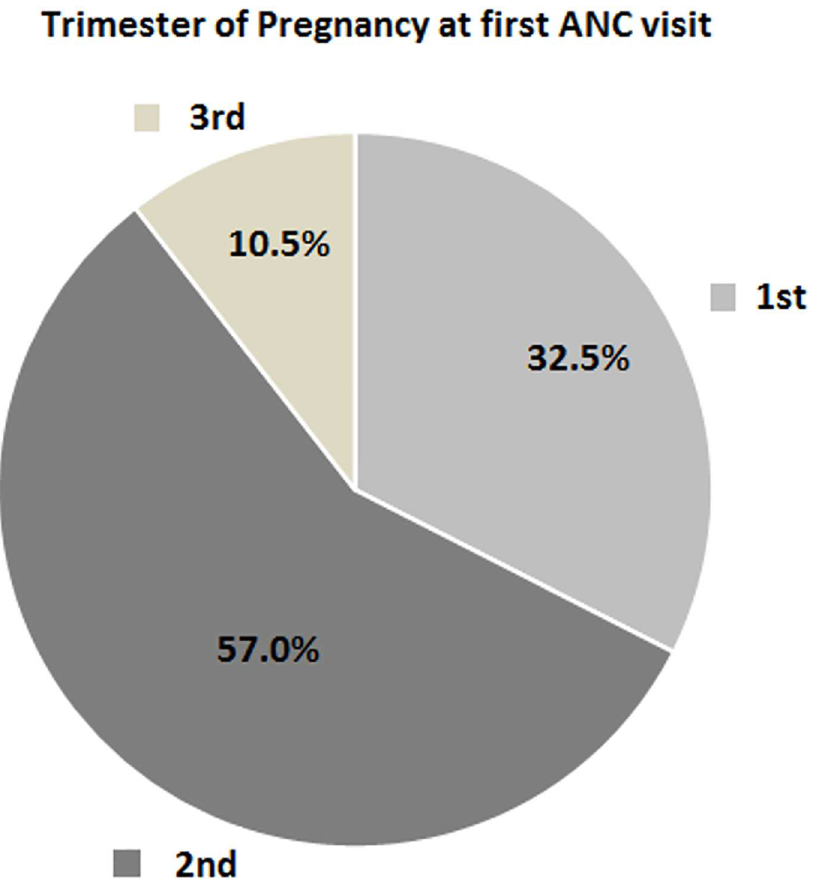
Fig 2. Proportions of pregnancies of women attending their first ANC visit in each of the three trimesters of pregnancy in the community of Bele´n, Iquitos, Peru 2010–2012.